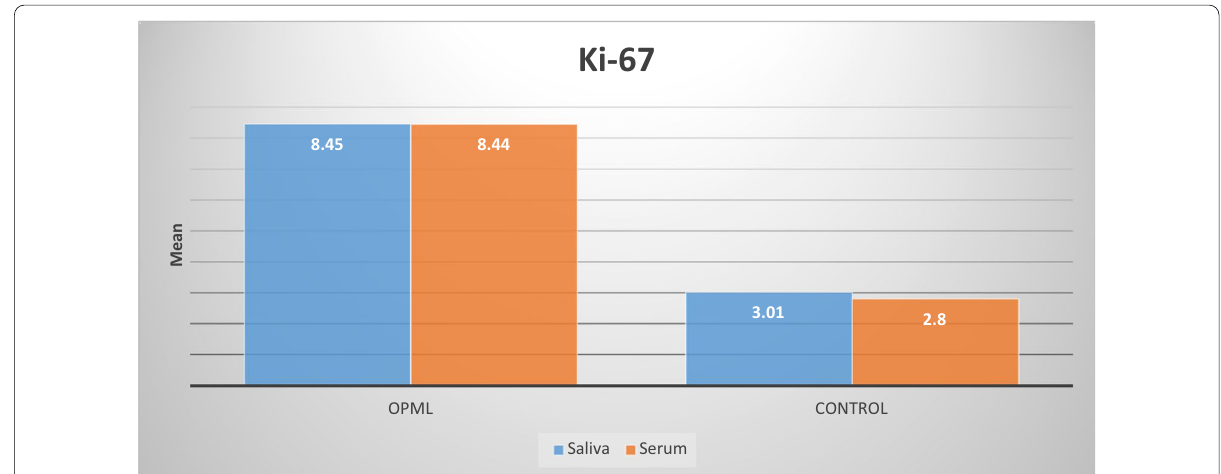
Fig. 15 Bar chart showing mean of KI-67 in saliva and serum regarding control and OPML